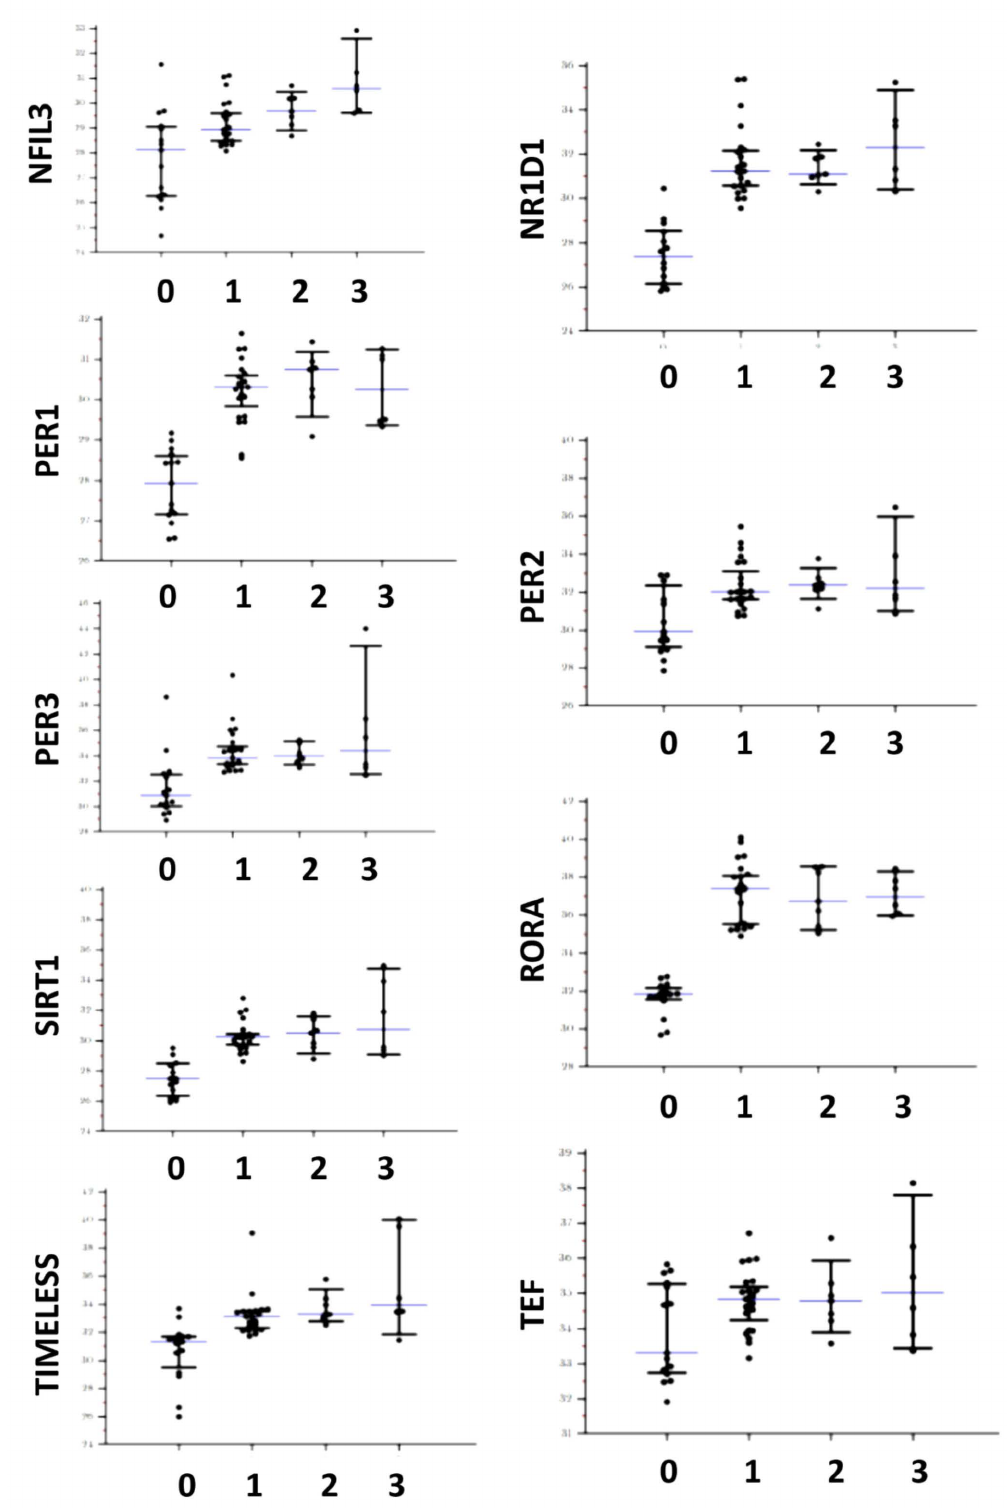
Figure 2. Distributions of gene expression in both controls and affected patients for NFIL3, NR1D1, PER1, PER2, PER3, RORA, SIRT1, TEF, and TIMELESS. The central line corresponds to the median, upper, and lower bars to the IQR. For the X axis label, 0 corresponds to controls, 1 to AIP, 2 to HCP, and 3 to CEP and